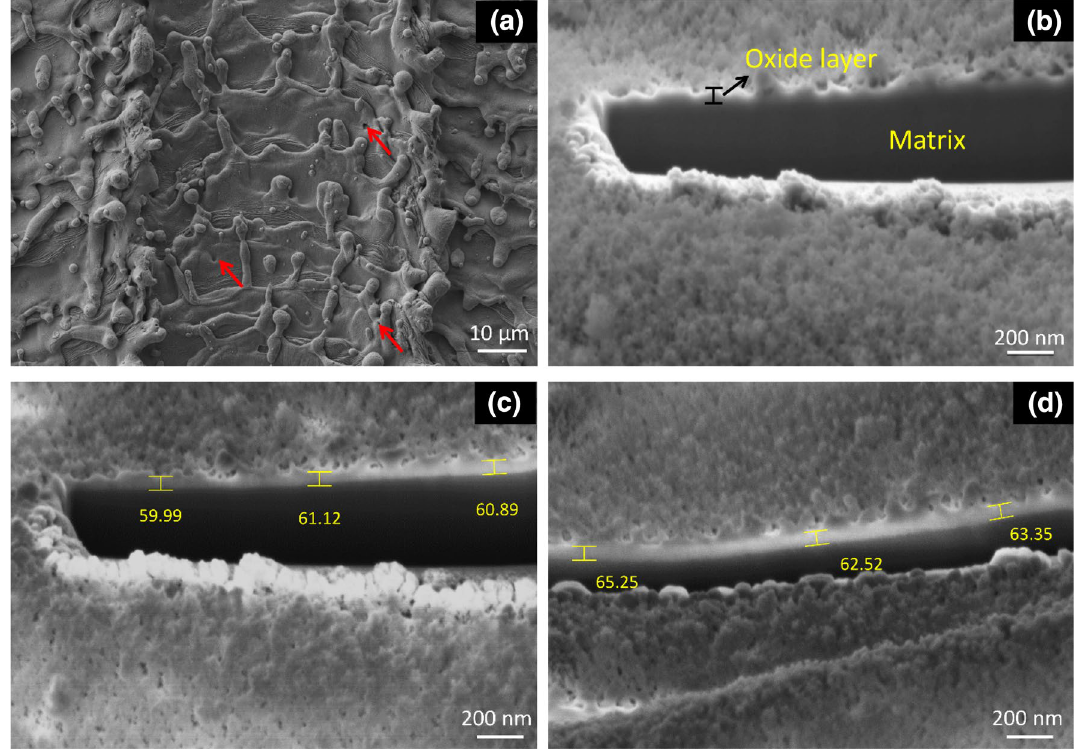
films coated samples (deposition times: c 10 s and d 20 s). The red arrows in ( a ) point to the presence of micropores on the surface after